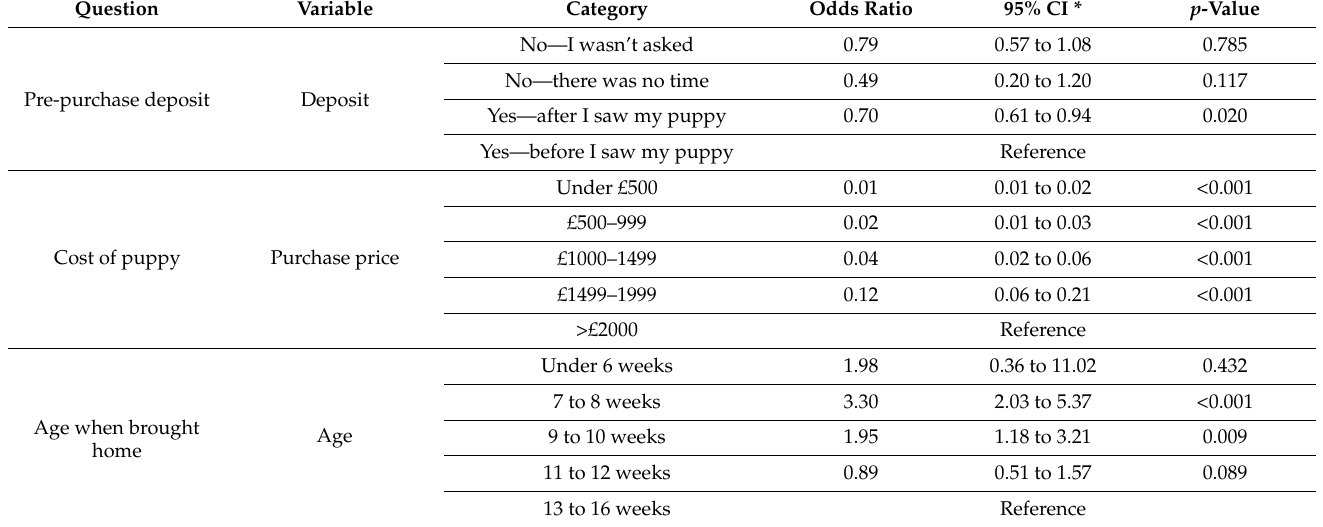
Table 15. Final multivariable model for purchasing behaviours associated with purchasing a ‘Pandemic Puppy’ in the UK during 2020. * Confidence